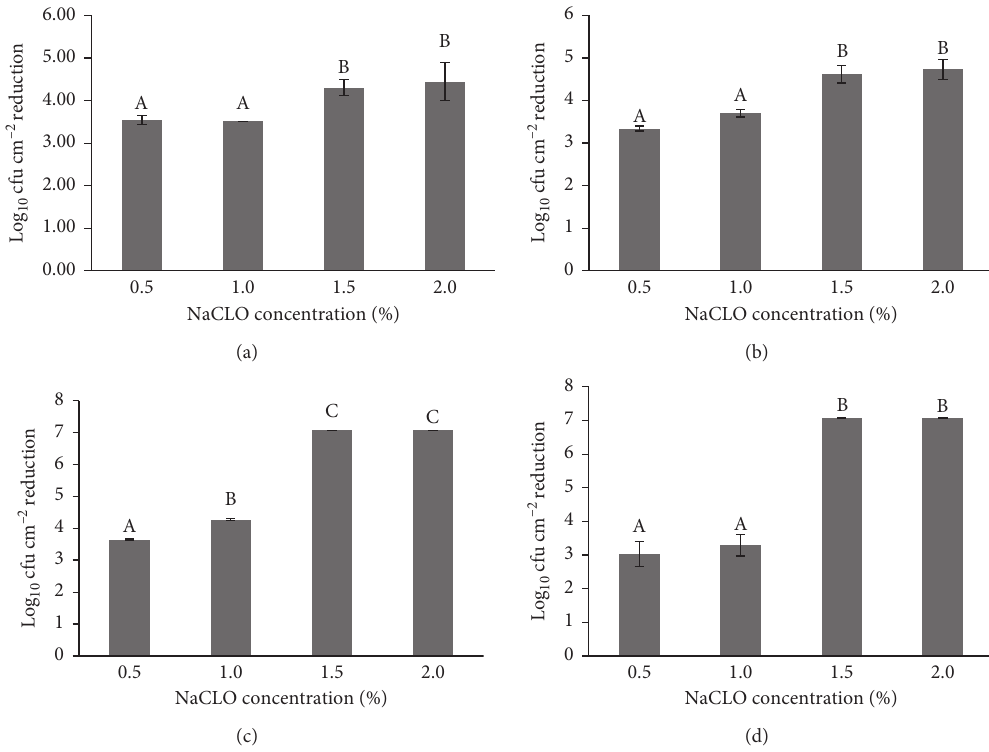
Figure 8: Number of P. aeruginosa biofilm cells reduced on the granite Gris Pinhel after 5 (a), 10 (b), 15 (c), and 30min (d) of sodium hypochlorite